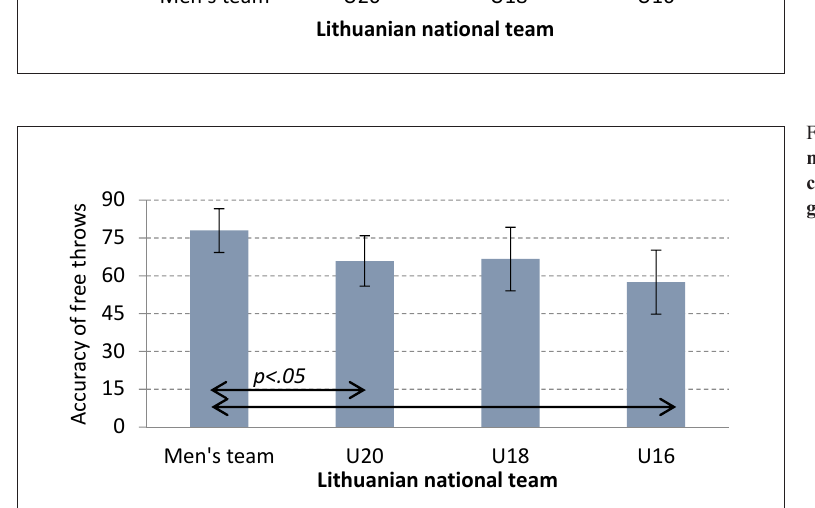
Figure 5. The number of free throws for men’s basketball teams in the European championship matches (average per one game)